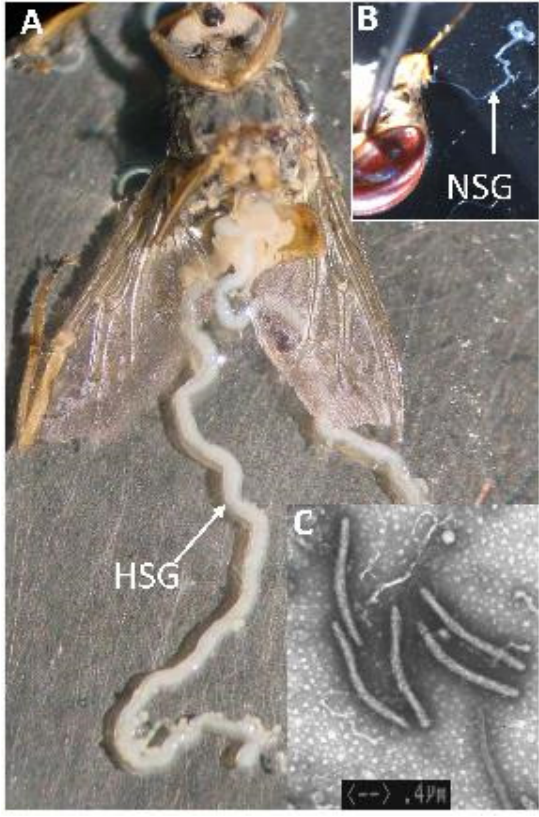
Figure 5. ( A ) Dissected adult Glossina pallidipes showing Hypertrophy Salivary Gland (HSG) symptoms caused by the Glossina pallidipes salivary gland hypertrophy virus (GpSGHV), ( B ) Nor- mal salivary gland (BGS) relative to the adults tsetse head, ( C ) Transmission electron microscopy (TEM) micrograph of GpSGHV virus particles